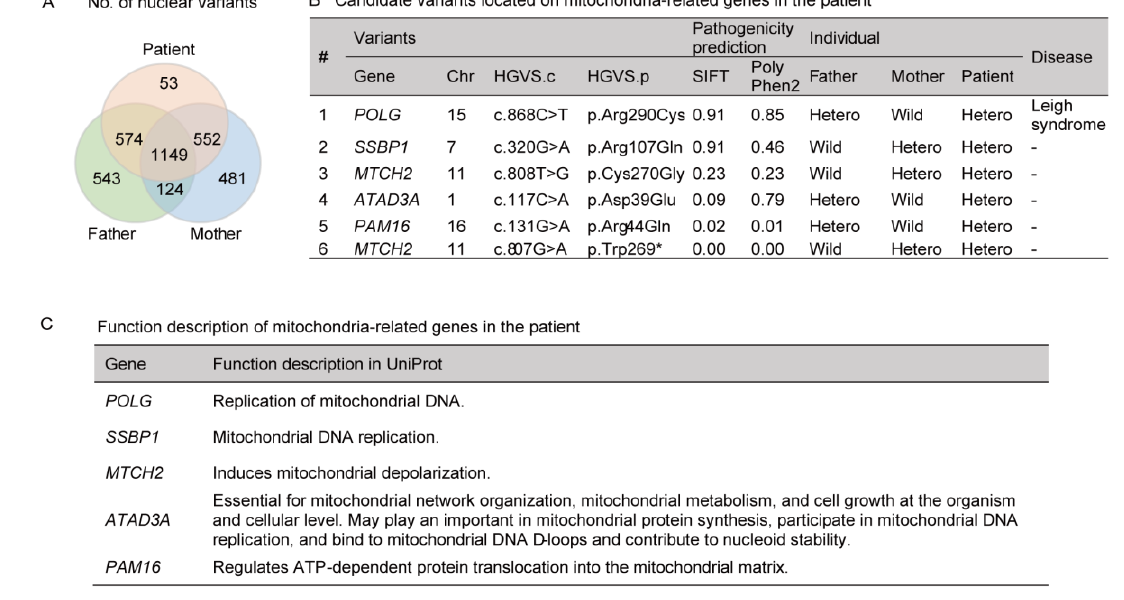
Figure 3. Candidate disease-causing variants from the PS patient identified by exome sequencing. ( A ) Venn diagram of the nuclear variants detected after exome sequencing of samples collected from the PS patient and his parents. A total of 2328 variants were detected in the PS patient. ( B ) Candidate variants were located in mitochondria-related genes in the PS patient. A total of six variants were selected as candidates for diseases with minor allele frequencies of <0.03 in the general population. Variants were listed in order of their pathogenicity prediction ranking. Polymorphism Phenotyping v2 (PolyPhen-2) and sorting intolerant from tolerant (SIFT) are in silico prediction tools for pathogenicity assessment. HGVS.c, Human Genome Variation Society, coding DNA reference sequence; HGVSs.p, Human Genome Variation Society, protein reference sequence; Hetero, heterozygous mutation; Disease, disease prediction based on the GATK analysis pipeline. ( C ) Functional description of the mitochondria-related genes in UniProt. Table 2. mtDNA deletions associated with POLG mutations for various diseases. Mutation in POLG mtDNA De- POLG Exon Disease/Clinical Features (Allele/Allele) letion